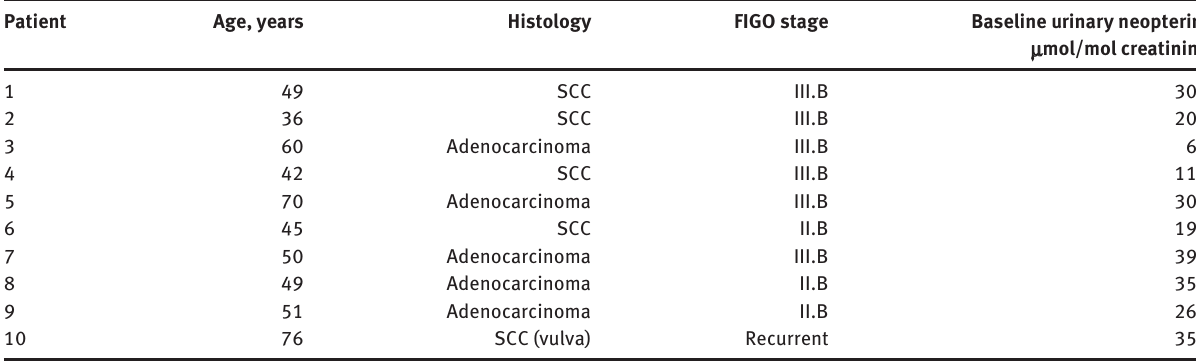
FIGO, Fédération Internationale de Gynécologie et d′Obstétrique; SCC, squamous cell